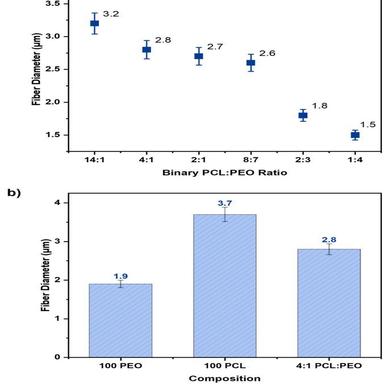
a) The effect on average fiber diameter by increasing the PEO ratio in the PCL:PEO (14:1-1:4) binary system and b) average fiber diameter of PEO, PCL, and optimized PCL:PEO composites.